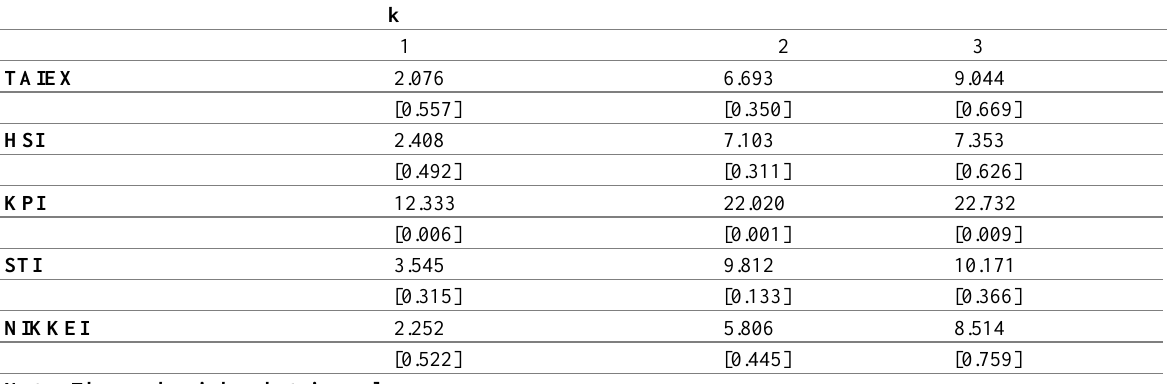
Table 3: LM tests of parameters constancy for k=1, 2, and